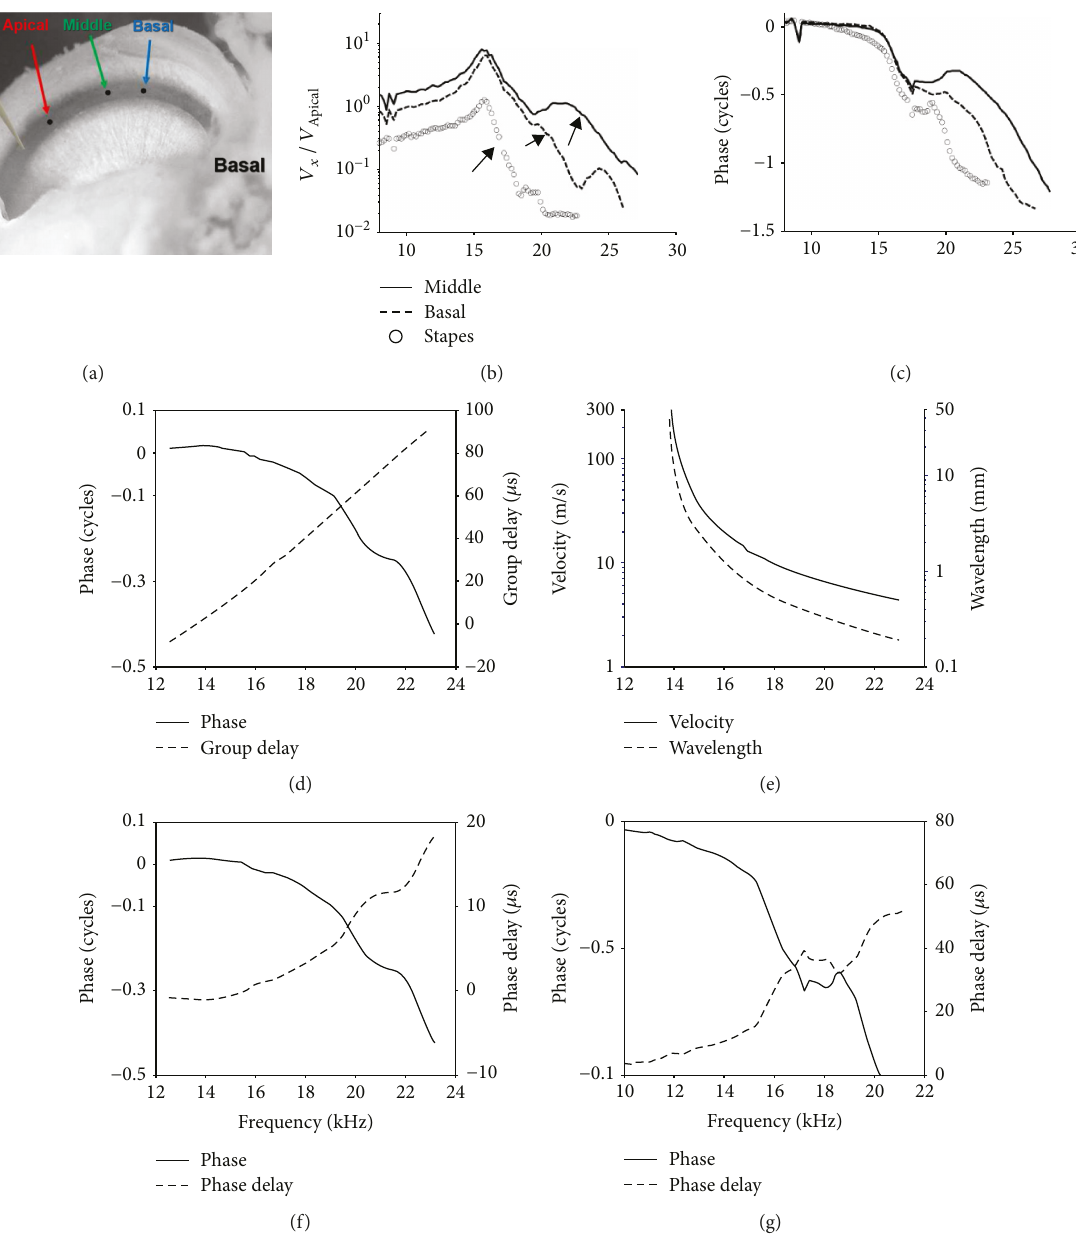
Figure 1: BM and stapes vibration spectra induced by a point stimulation of the BM. (a) The opened cochlea with stimulator and re fl ective beads in place. The stimulator probe is a blunt pipette driven by a piezoelectric stack. Re fl ective beads are placed on the BM, labeled as apical, middle, or basal, in the direction away from the stimulator. A bead was also placed on the stapes for recording its vibration. Vibration amplitude (b) and phase (c) of the middle (solid), basal (dash), and the stapes (circle) beads, relative to that of the apical bead. (d) Phase di ff erence (solid) between the middle and basal beads and the calculated group delay (dash). (e) Wave velocity and the wavelength, calculated from the phase di ff erence in D . The negative delay value at lower frequencies ( < 14 kHz) in both (d) and (e) is likely due to a local disturbance, such as the local re fl ection with the insertion of the stimulator. The wave speed is high at lower frequencies, and the distance between these two beads is small. Both e ff ects make it vulnerable to the disturbance. For a wider range, apical to stapes, this small negative delay is absent (g). (f) Phase di ff erence (solid) between the middle and basal beads and the calculated phase delay (dash). (g) Phase of the stapes vibration (solid) relative to the apical bead and the calculated phase delay